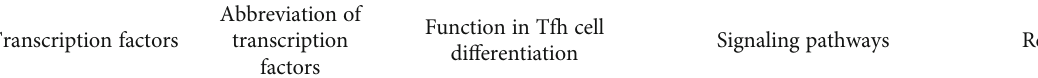
Table 1: Transcription factors in the di ff erentiation of Tfh